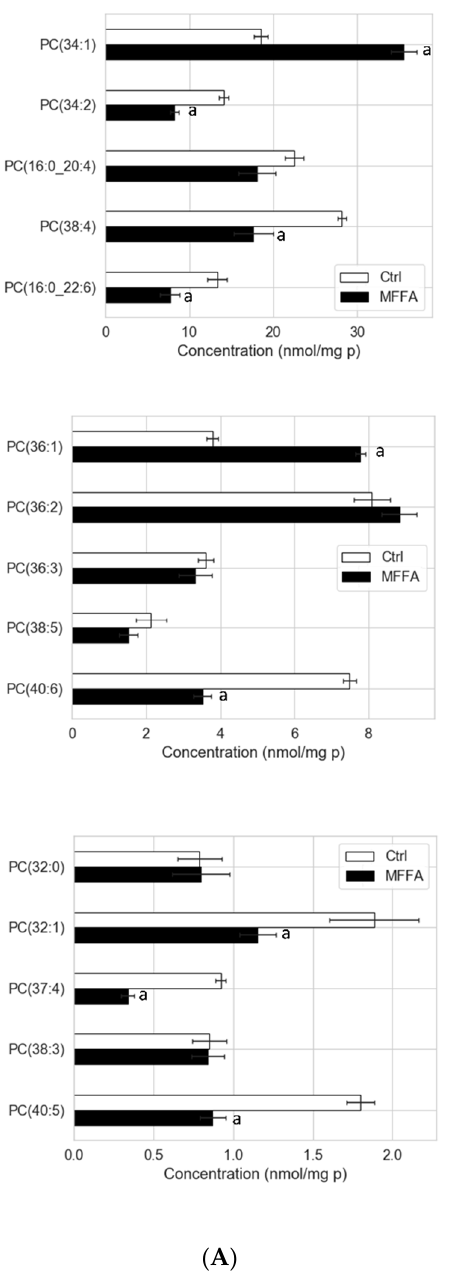
Figure 2. Dose effects of MFFA on the selected PC and PE species. Isolated rat hepatocytes were treated with 0 or 2 mM of MFFA for 24 h. The top 15 PC and PE species in concentrations (nmol/mg protein) were determined by LC-MS lipidomic analysis and shown here ( A , B ). Lipid species in each lipid class are separated into three panels based on their abundances. Data shown as mean ± sem; a: p < 0.05 vs. Ctrl (0.0 mM) group as determined by Mann–Whitney U test; * indicates the comparison is only significant for the post hoc test, but not the Kruskal–Wallis test ( n = 4).